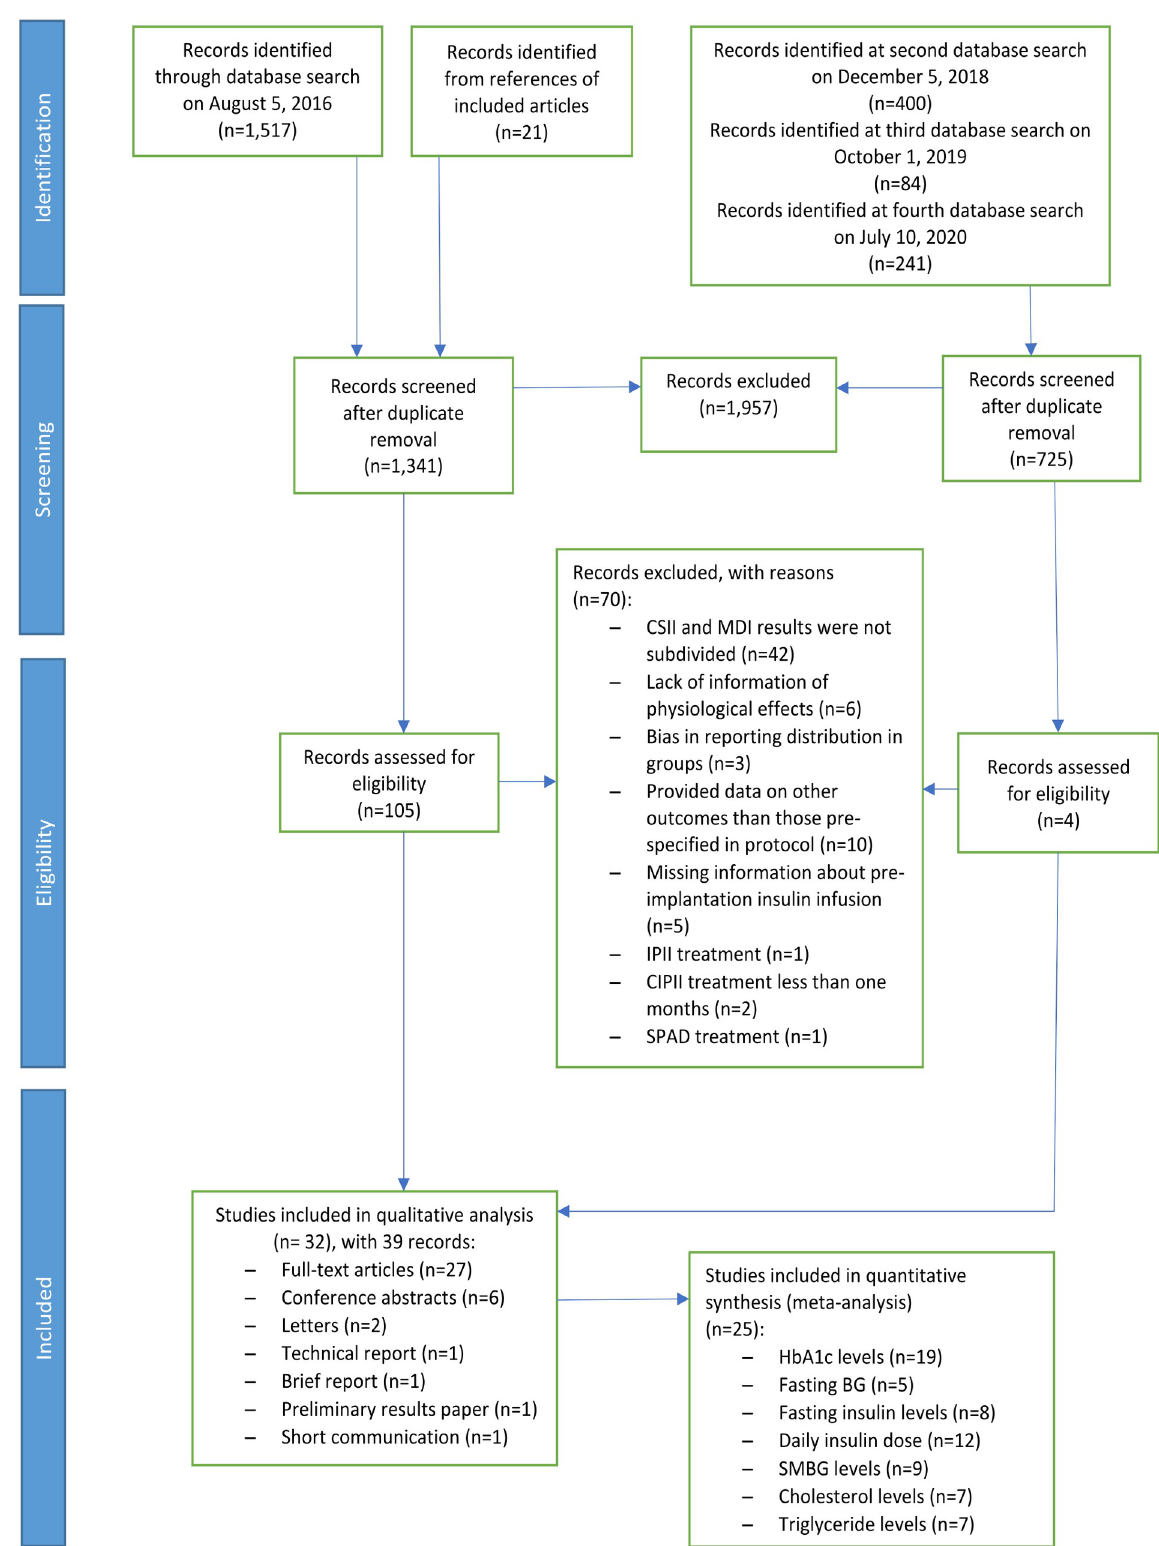
Fig 1. Flow chart of the screening and selection of included studies.